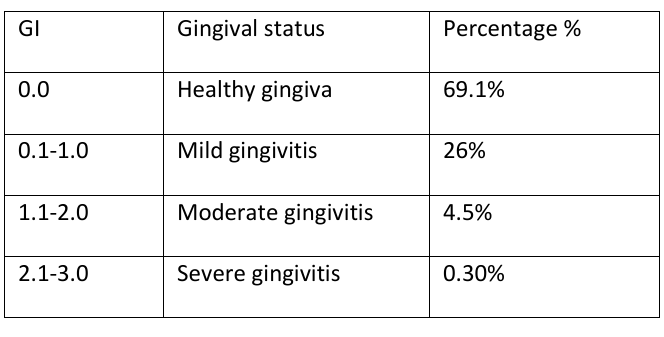
Table 2: Percentile of school students according to gingival status: